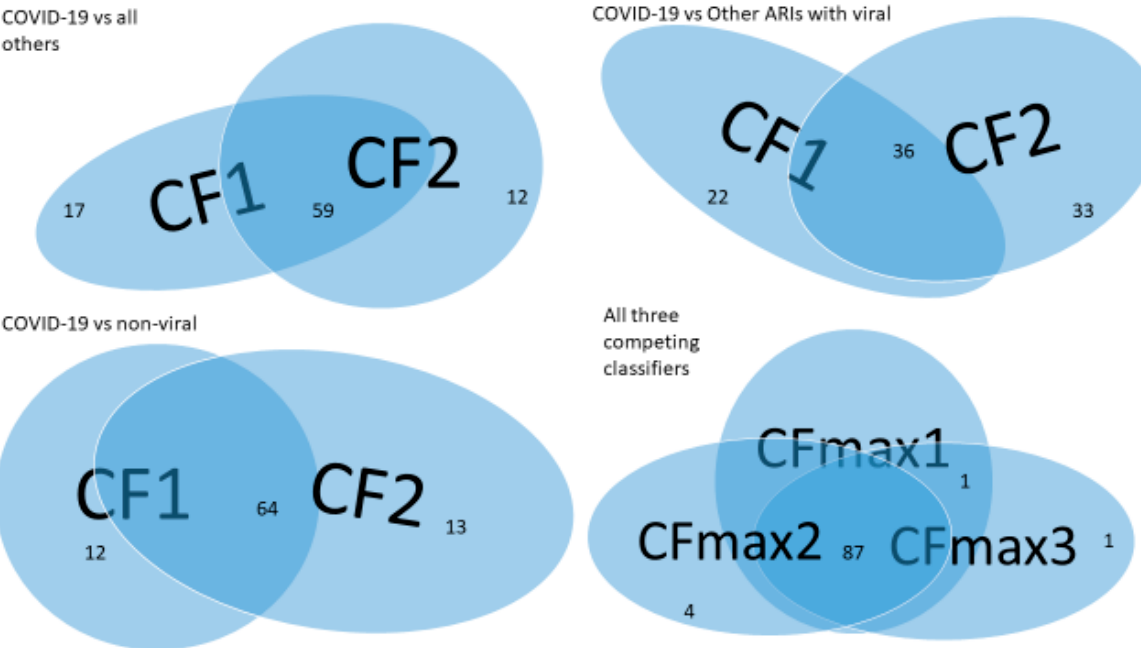
Figure 2. Venn diagram of variants of SARS-CoV-2 (the first dataset): Top-left panel is for COVID- 19 vs. all others; Top-right panel is for COVID-19 vs. other viral infections; Bottom-left panel is for COVID-19 vs. non-viral infections; Bottom-right panel is for all three together. Comparing the individual classifiers and combined classifiers among COVID-19